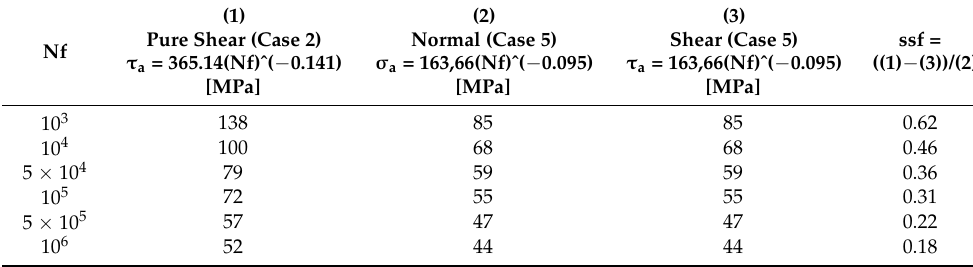
Table 8. ssf results for Case